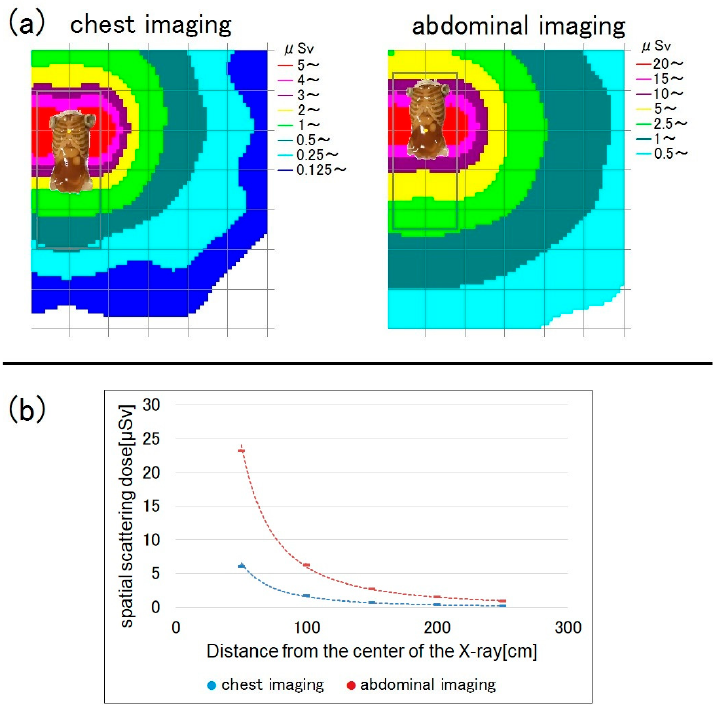
Figure 7. Comparison of the spatial scattered radiation dose between chest and abdominal imaging (bed height = 80 cm, measurement height = 150 cm). ( a ) Dose-distribution map and ( b ) graph showing the spatial doses.